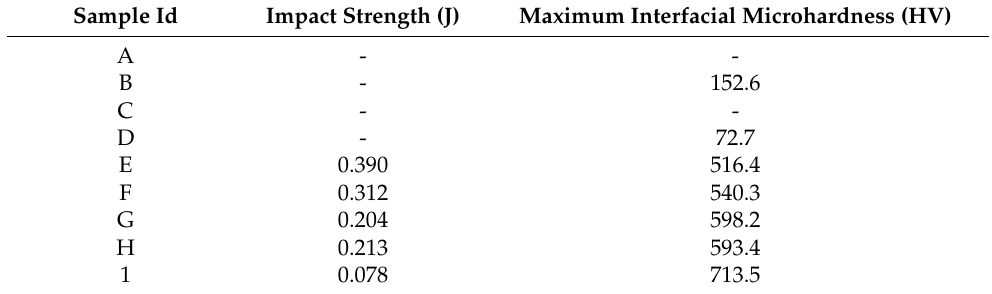
Table 4. Impact strength and the maximum interfacial microhardness of the bonded metal. Sample